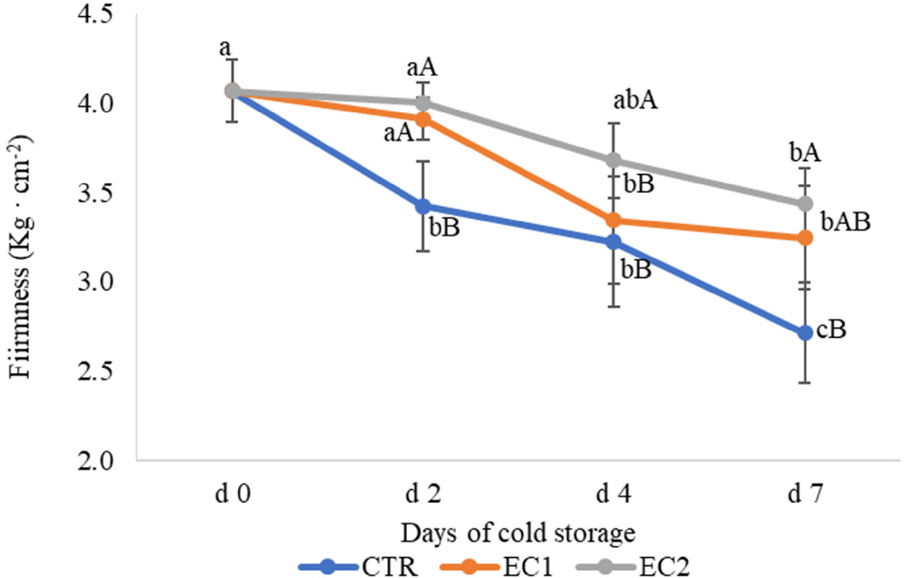
Figure 1. Development of firmness (Kg cm − 2 ) of treated (EC1 and EC2) and untreated (CTR) pear slices. Data correspond to the means ± standard deviation of three replicates. Means with different letters are significantly different at p ≤ 0.05 using Tukey’s-HSD test. Different lowercase letters denote significant differences ( p < 0.05) between different sampling times for the same treatment. Different capital letters denote significant differences ( p < 0.05) between different treatments for the same sampling time.